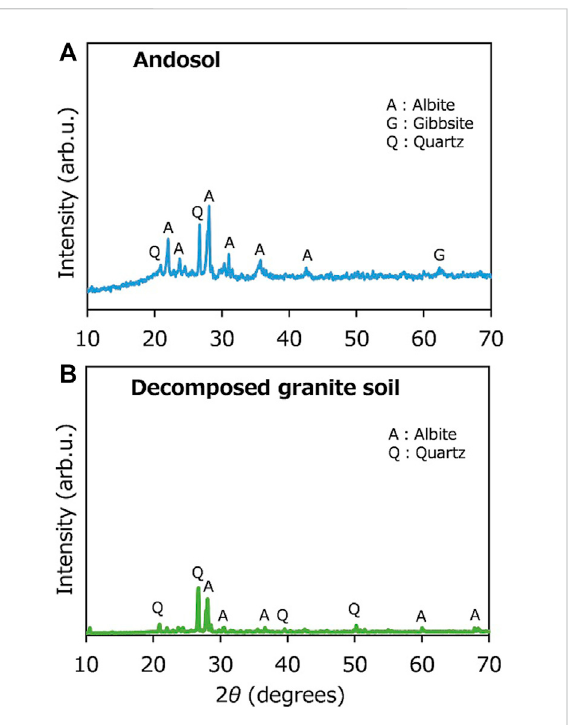
FIGURE 2 X-ray diffraction patterns observed in the experiment for (A) andosol and (B) decomposed granite